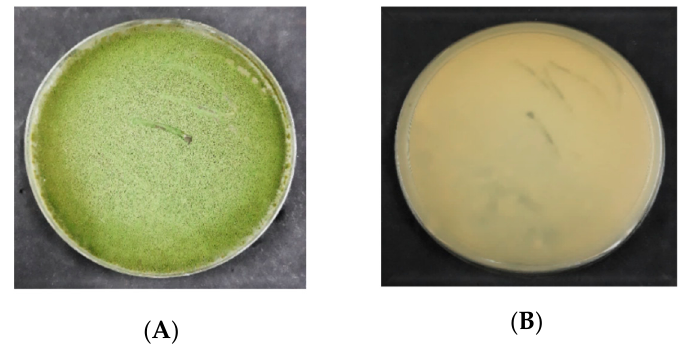
Figure 2. Colony morphology of A. flavus on the potato dextrose agar (PDA); ( A ) = obverse, ( B ) = reverse.